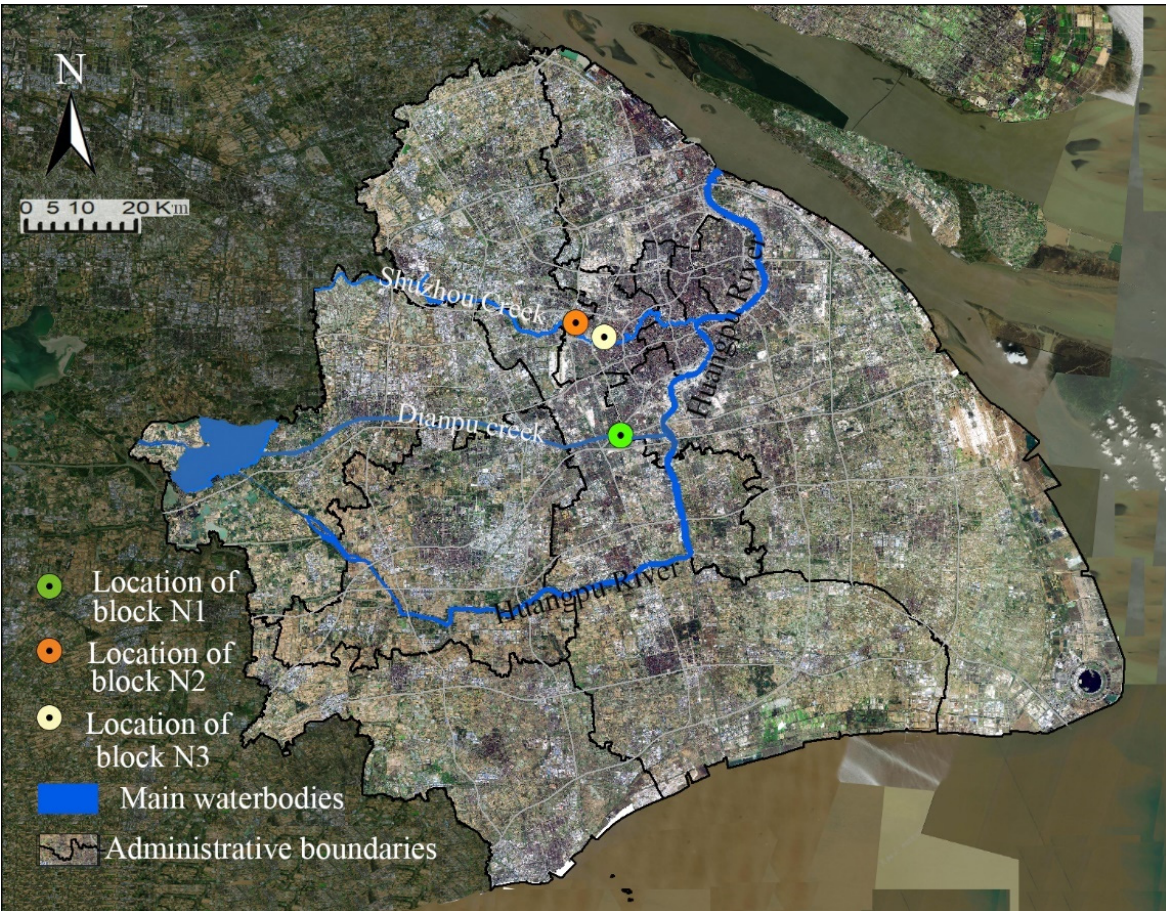
Figure 1. Location of the three study areas in Shanghai, China.